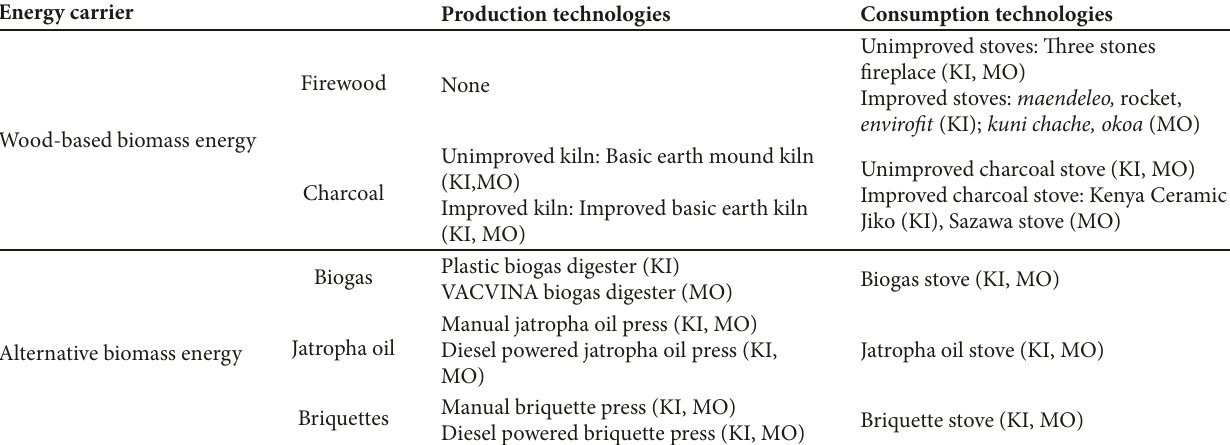
Table 1: Considered biomass fuels and their production and consumption technologies in Kitui (KI) and Moshi